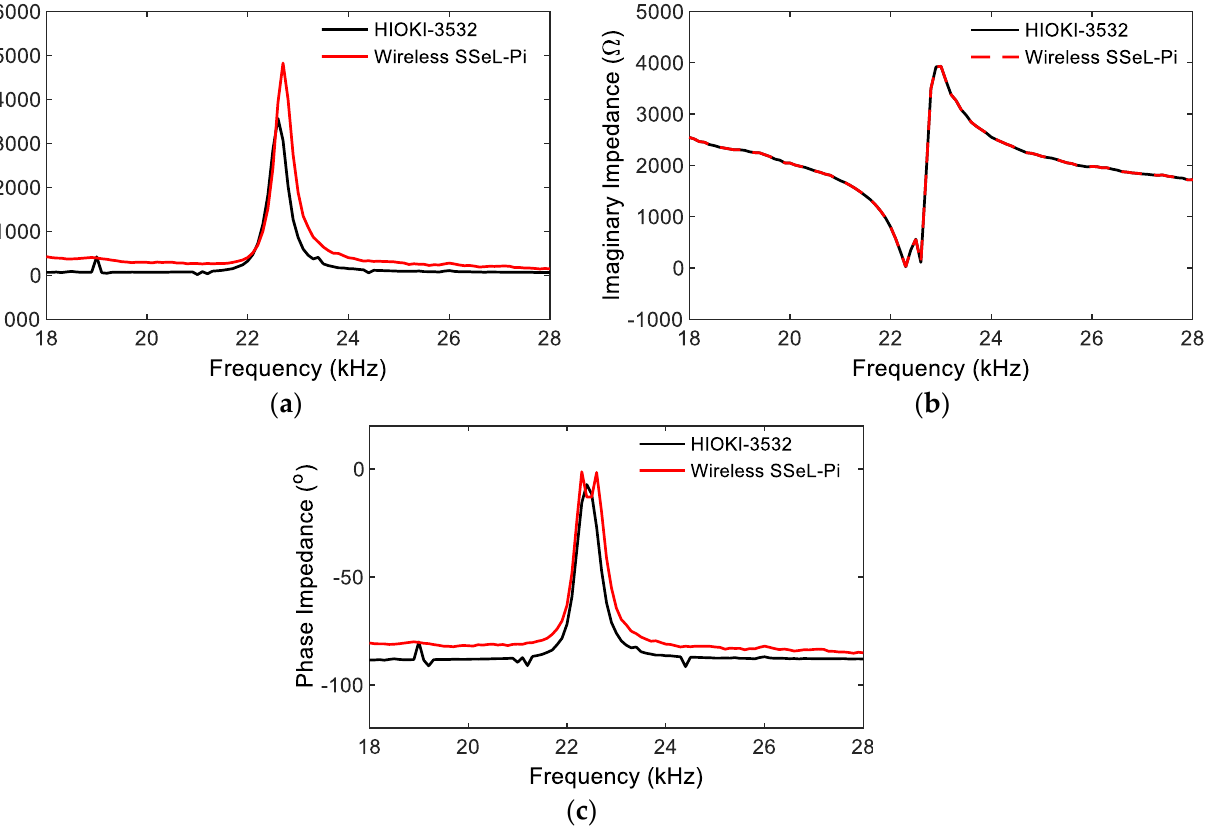
Figure 17. Performance of impedance calibration between SSeL-Pi and HIOKI-3532. ( a ) Real impedance R C , ( b ) Imaginary impedance I C , ( c ) Phase impedance ϕ C